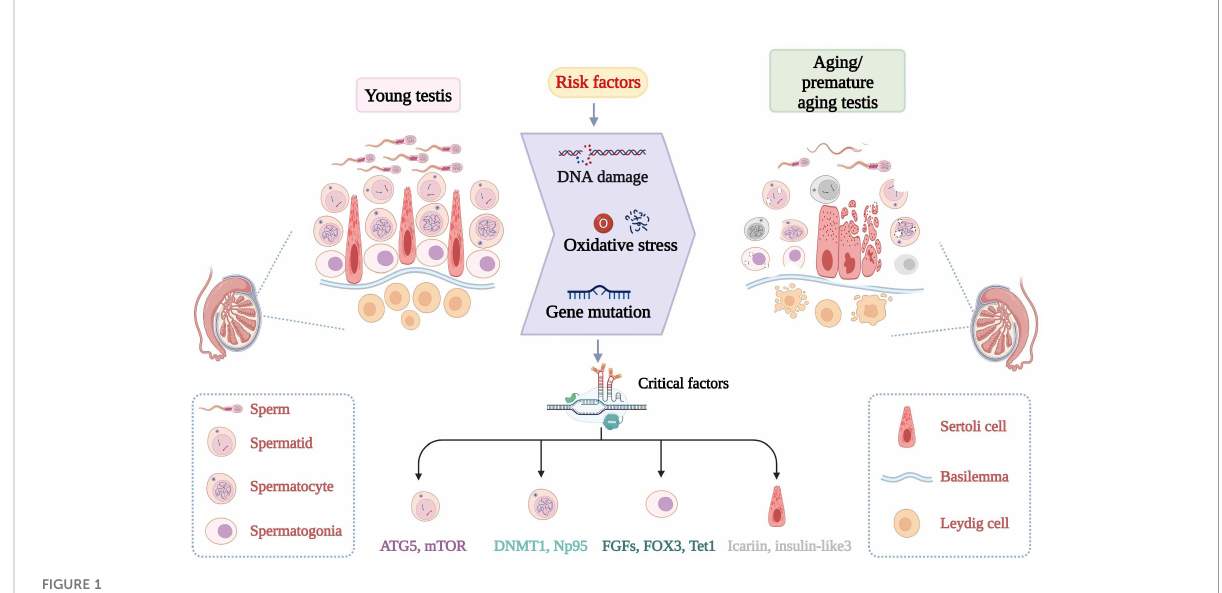
FIGURE 1 Discrepancy of normal spermatogenesis and senescent spermatogenesis. In young testes, spermatogenesis continues through a series of speci fi c steps. In aging testes, spermatogenesis is impaired with age. Increased risk factors and critical molecular aberrant cause adverse changes in the morphology and number of germ cells. Changes in key molecules such as FOX3 can lead to testicular DNA damage, increased oxidative stress and so